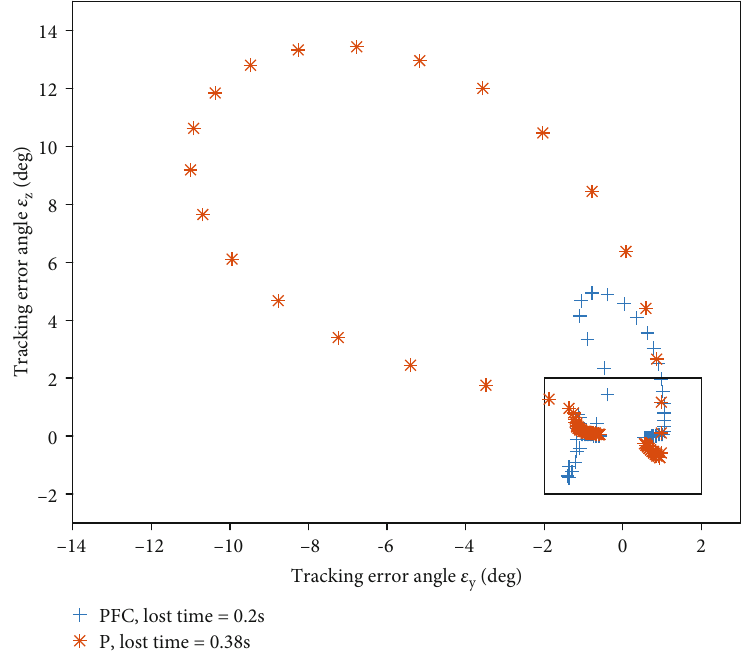
Figure 11: Tracking errors of PFC and PI (1 deg,